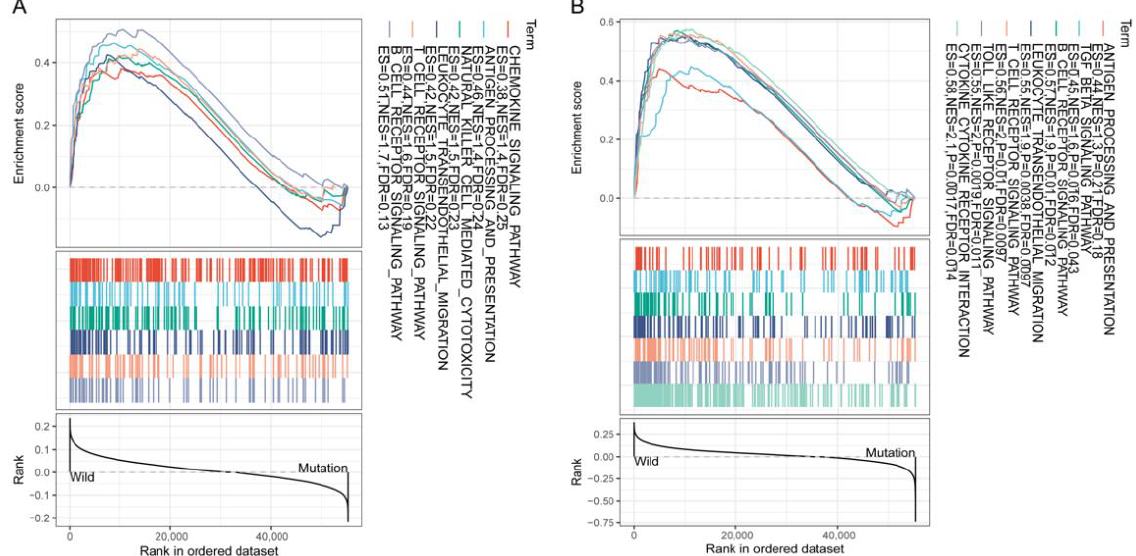
of immune cell infiltration induced by mutation in FAT1 (lower).